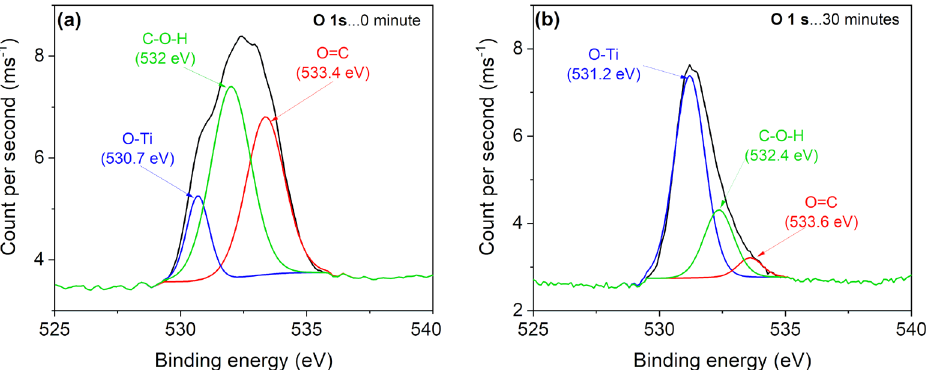
Figure 8. The measured and fitted XPS spectra attributed to O before etching ( a ) and after 30 min of Ar n+ etching ( b ). Table 2. Atomic percentages of the elements at the surface of sample Pt200 determined from the XPS after various times of Ar n+ etch.